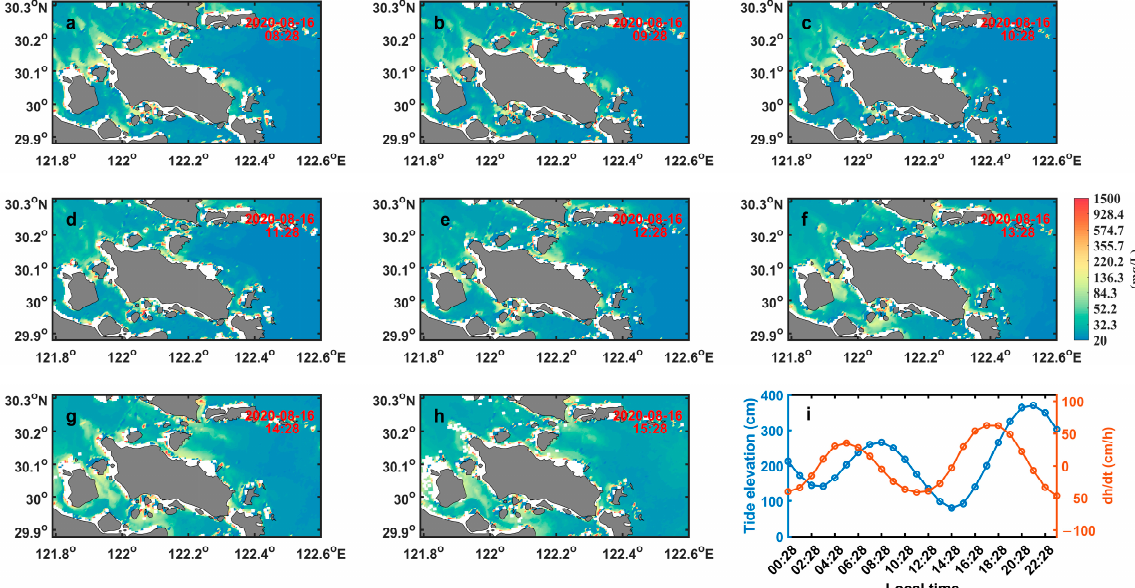
Figure 12. Same as Figure 10 but for the spring tide on 20 August 2020.